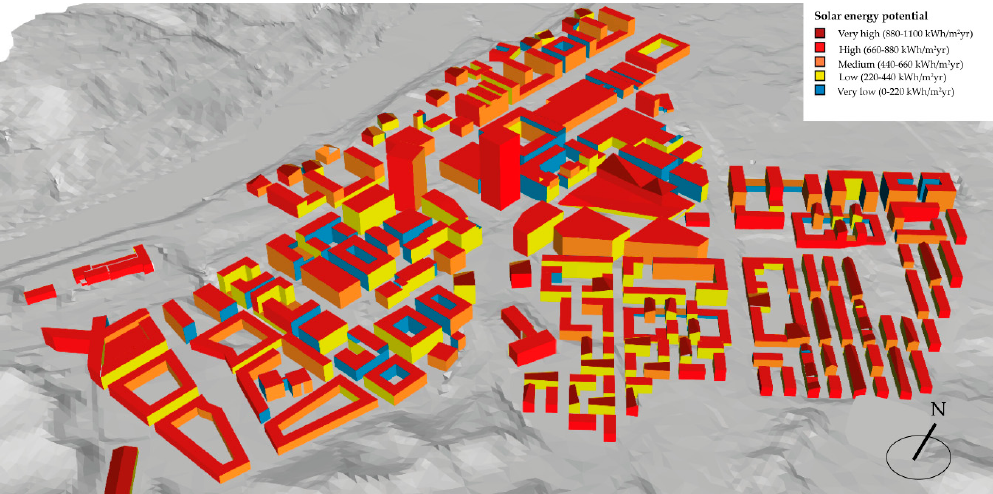
Figure 14. Three-dimensional visualization of the solar map for feasibility study II. Figure 15. Three-dimensional visualization of the solar map for feasibility study